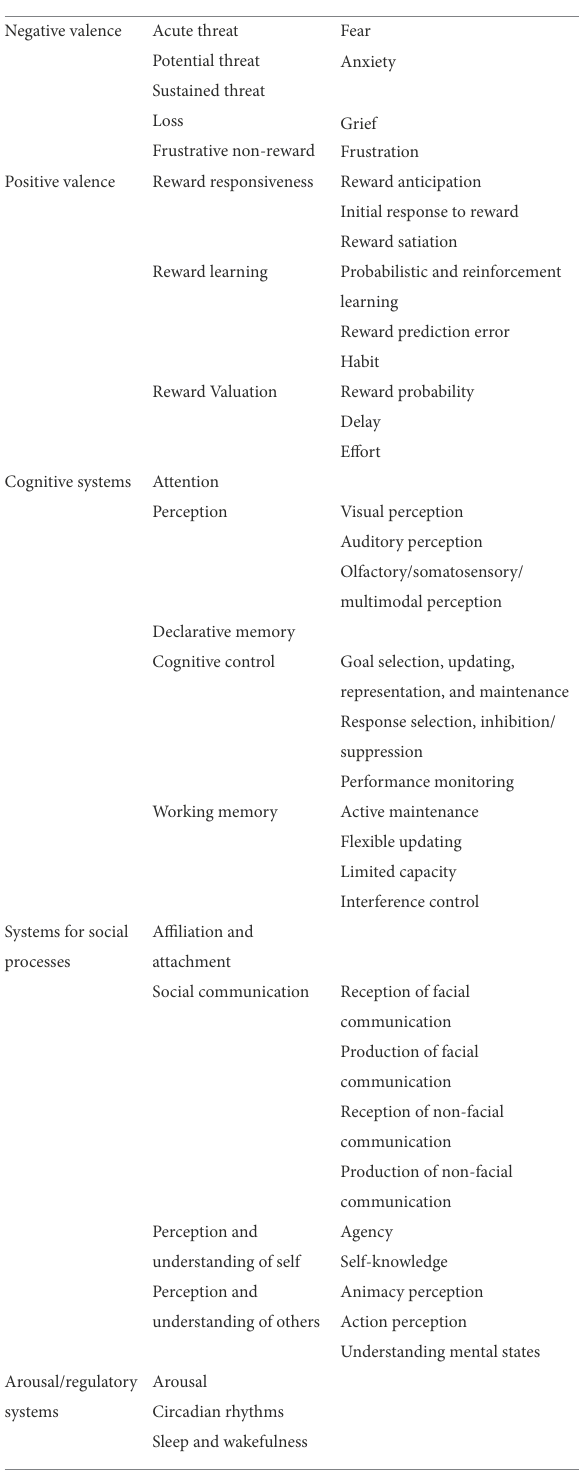
TABLE 1 A simplified representation of the RDoC